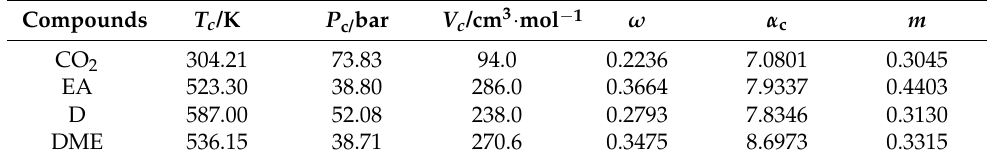
Table 3. Critical data ( T c , P c , V c ), acentric factor ( ω ) [33], and GEOS parameters ( α c , m ) for pure compounds.